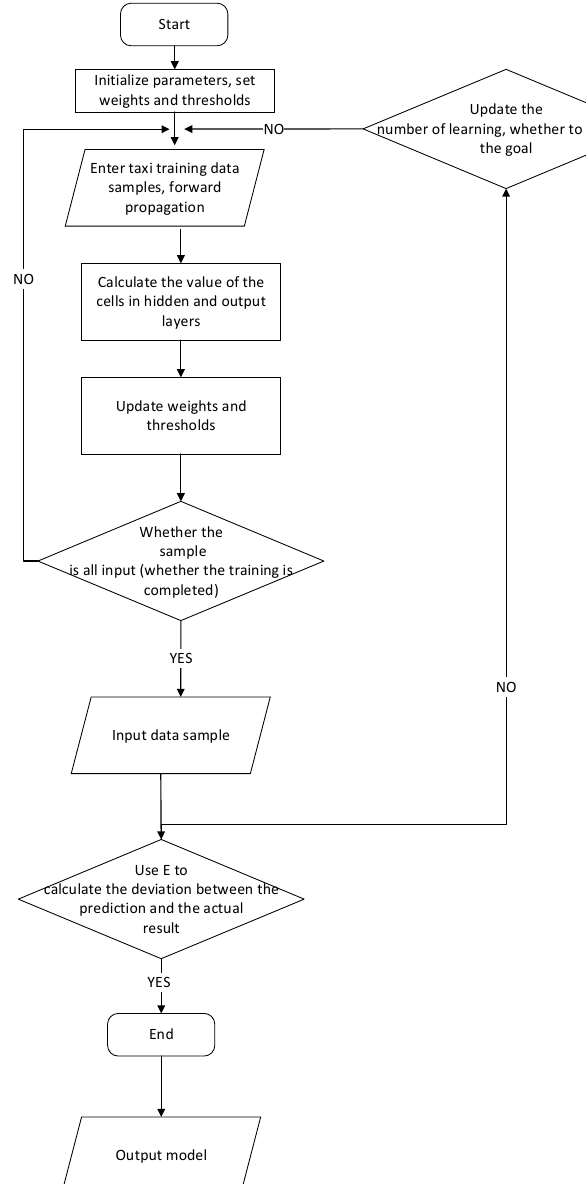
Figure 7. Spatio-temporal feature optimization neural network flow. Figure 7. Spatio ‐ temporal feature optimization neural network flow. The forecasting process for the taxi passengers’ waiting times based on the spatio- temporal feature-optimized neural network model is as